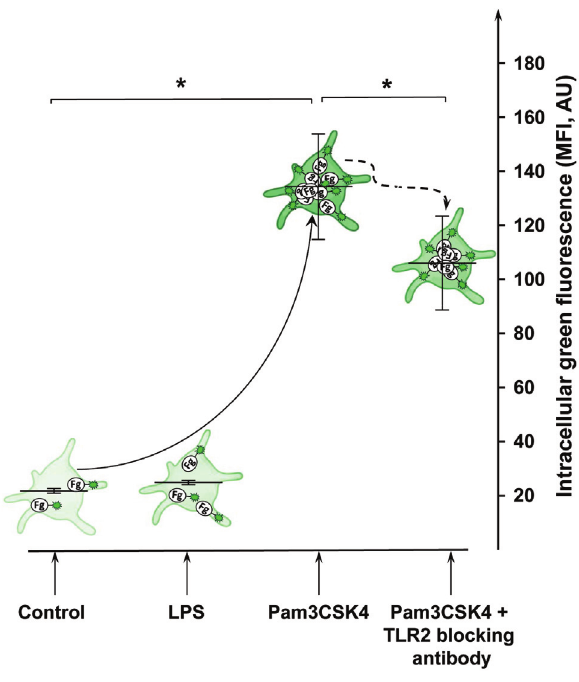
Fig. 6 TLR2 stimulation activates fi brinogen uptake in platelets. The schematic illustration shows changes of intracellular green fl uores- cence in platelets stimulated with 15 µg/mLof Pam3CSK4 or 15 µg/mL of LPS in the presence of Alexa Fluor 488-conjugated fi brinogen (green). Data are presented as mean MFI (cid:3) SEM; n ¼ 12; (cid:4) : p < 0.05; compared with control. LPS, lipopolysaccharides; SEM, standard error of mean; TLR, toll-like